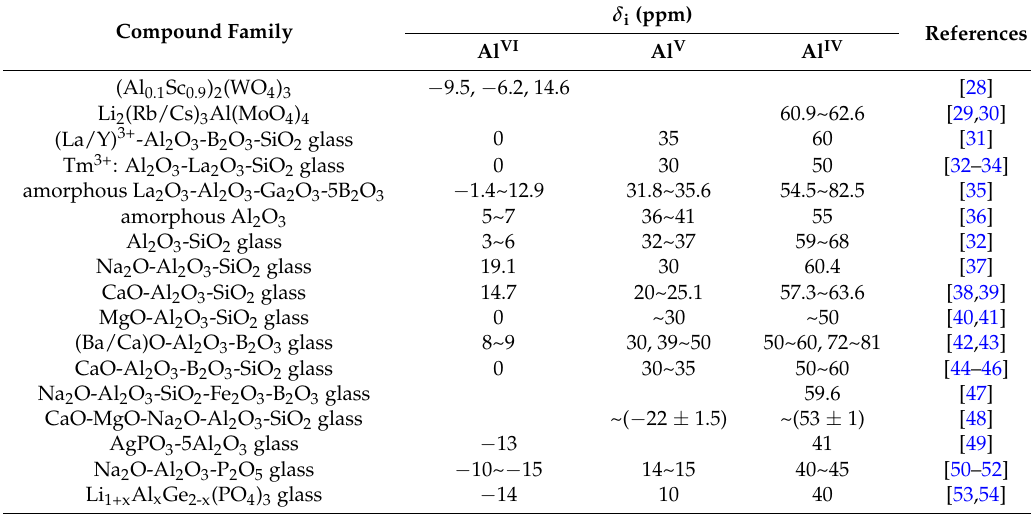
Table 1. The chemical shift values of four-, five-, and six-coordinated Al species (Al IV , Al V , and Al VI , respectively) in various inorganic salt systems determined by 27 Al nuclear magnetic resonance